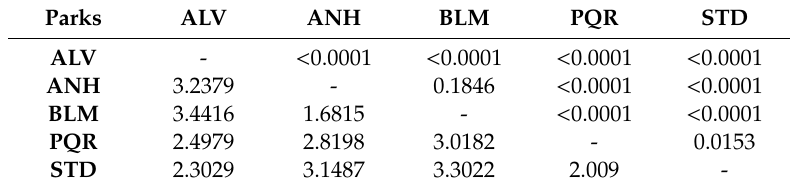
Table 2. Mahalanobisdistances(belowdiagonal)and p values(abovediagonal)for Ae. scapularis populations. Parks ALV ANH BLM PQR STD - < 0.0001